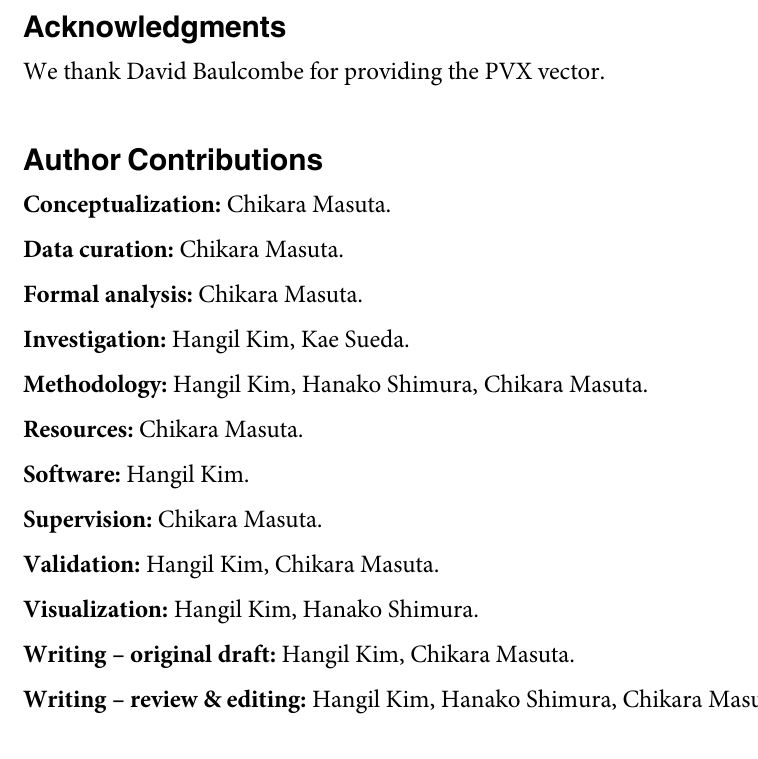
S1 Table. Primers used for cloning and real-time PCR.